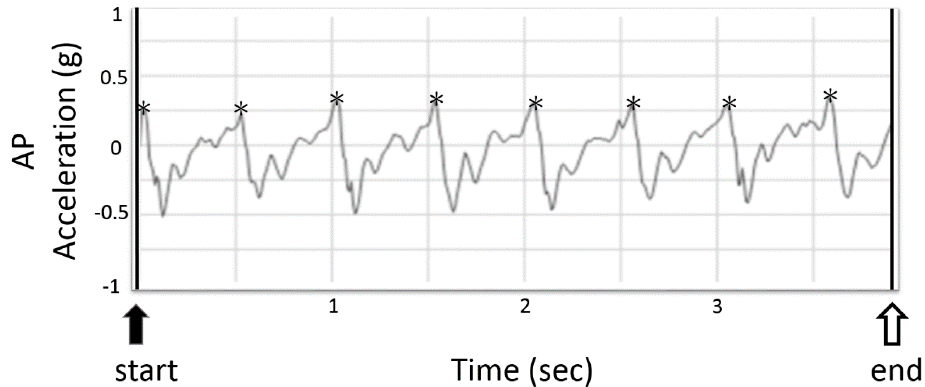
Figure 5. The typical plot of anterior-posterior (AP) acceleration signals from the tri-axial accelerometer during 5 m of normal walking samples at 100 Hz. The two black bars represent the moment of infrared-defined gait initiation and termination and the black arrowhead indicates the start of the measurement. The white arrowhead indicates the end of the measurement. The asterisks around peak acceleration values indicates initial foot contact of each integer step.